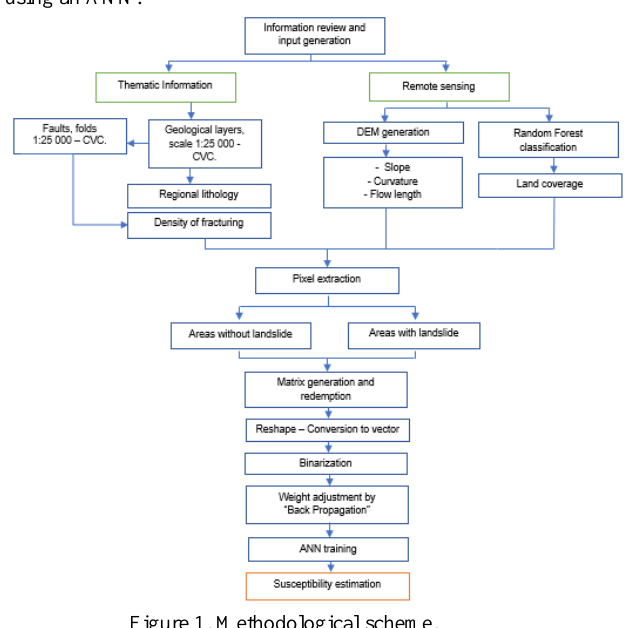
Figure 1. Methodological